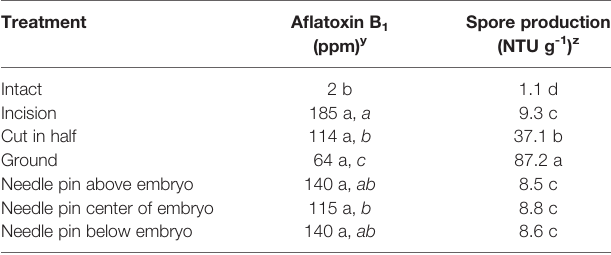
y Values, in parts per million (ppm), correspond to a fl atoxin B 1 means of 10 replicates from two independent similar tests. In each treatment, values with different lower-case letters indicate signi fi cant differences for log transformed data of a fl atoxin B 1 ppm by Fisher ’ s LSD ( a =0.05). Lower-case letters in italics following the comma indicate signi fi cant differences among treatments excluding intact treatment. z Values are AF13 reproduction rates in NTU g -1 (NTUs: nephelometric turbidity units, 1 NTU = 49,937 spores). Values are means of 10 replicates from two independent similar tests. Values with different lower-case letters indicate signi fi cant differences for log transformed data of NTUs by Fisher ’ s LSD ( a